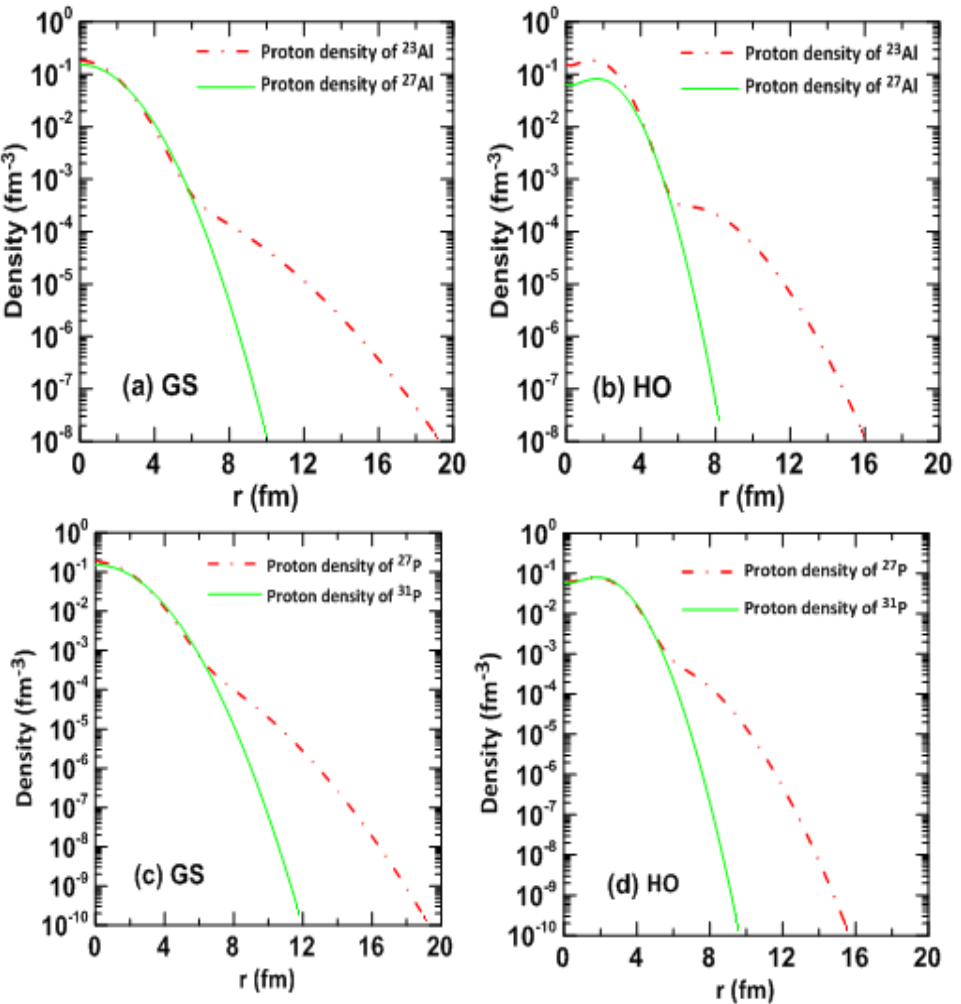
Fig. 4: The proton density distributions for isotopes pairs 27,23 Al and 31,27